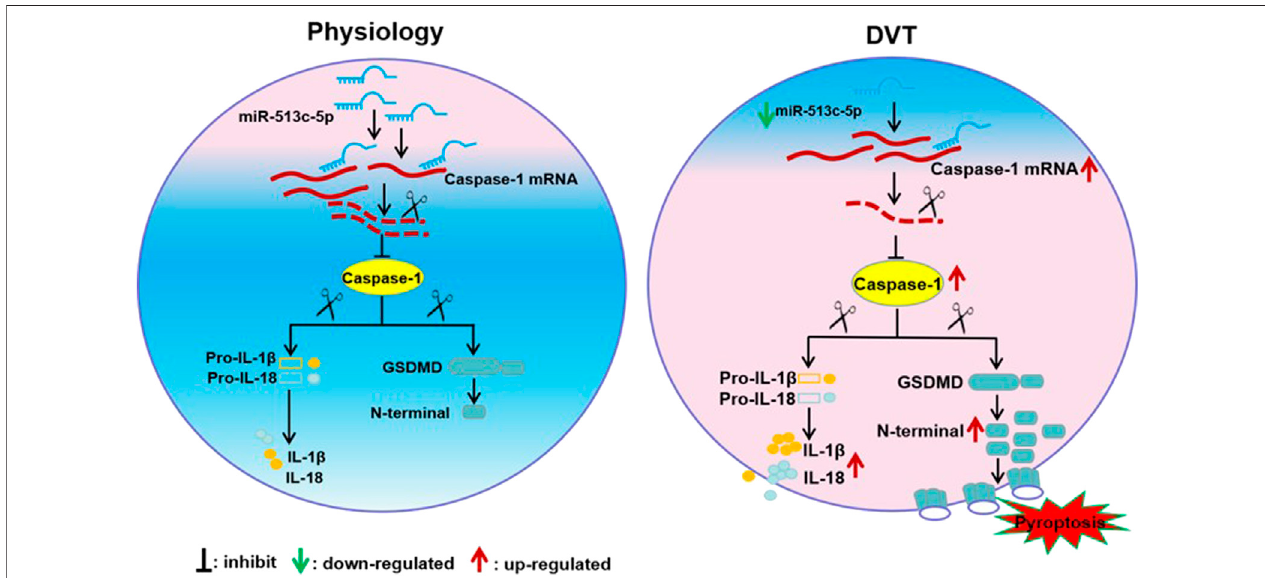
FIGURE 8 | Schematic diagram of miR-513c-5p/caspase-1/GSDMD signal axis alteration in DVT pathogenesis. The down-regulation of miR-513c-5p in vascular endothelial cells relieved the inhibition of caspase-1 expression and resultant enhances of pyroptosis caused injury of endothelial cell, which lead to DVT formation.